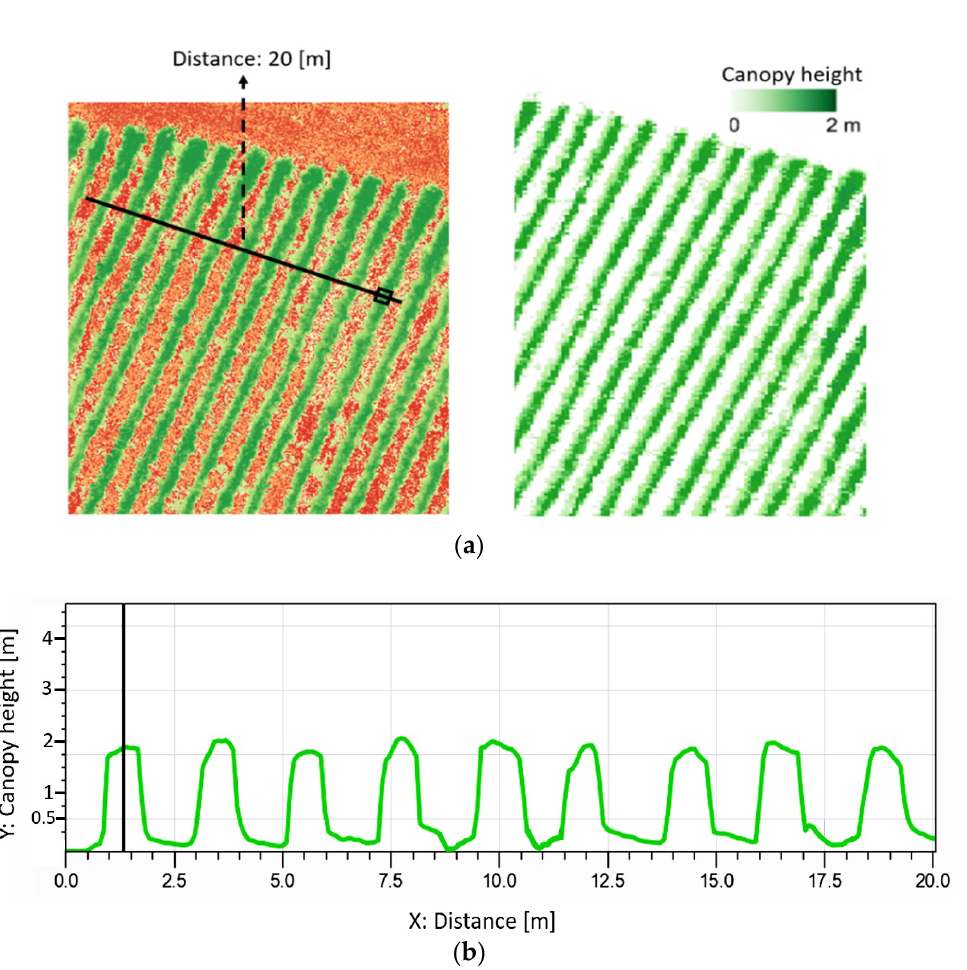
Figure 7. ( a ) Representation of the raster analysis using DEM information to extract the vineyard Crop Surface Model; ( b ) Diagram of Digital Elevation Model of vineyard canopies, the green line represents the CSM profile from the line traced over the vine rows.